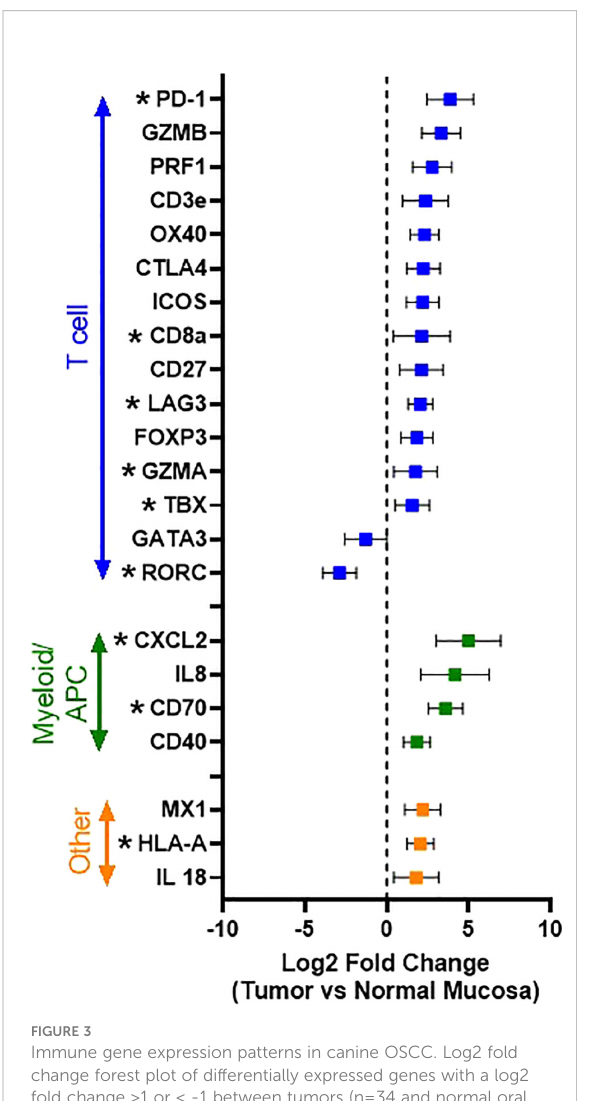
FIGURE 3 Immune gene expression patterns in canine OSCC. Log2 fold change forest plot of differentially expressed genes with a log2 fold change >1 or < -1 between tumors (n=34 and normal oral mucosa (n=2). Genes are groups according to their immune cell type and/or function. Data represents mean +/- S.D. * indicates signi fi cantly differentially expressed genes with an FDR-adjusted p-value <0.05.